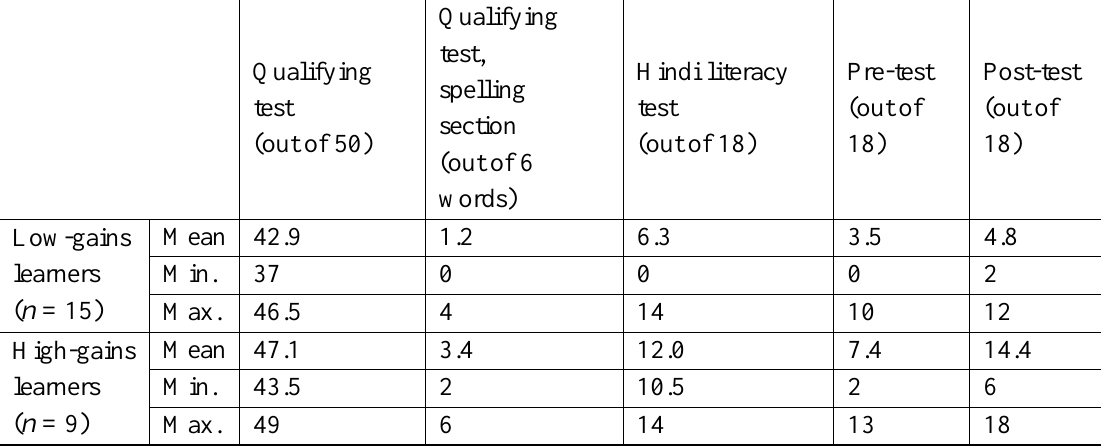
Hindi literacy test (out of 18)